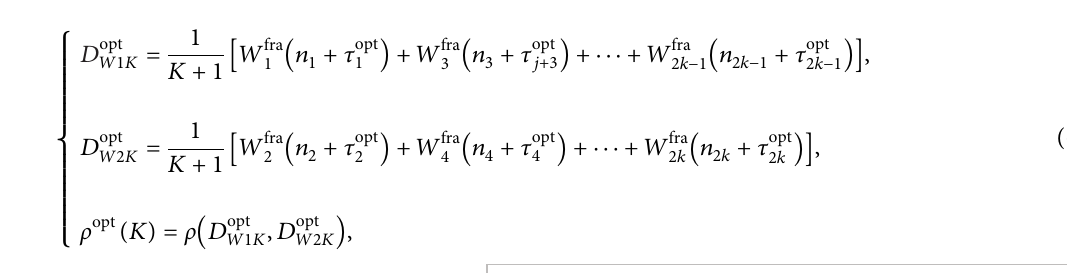
Figure 6: W fra i ( n j + τ j ) signal segment schematic diagram. The part selected by the blue frame is frame is W fra i ( n j + τ j